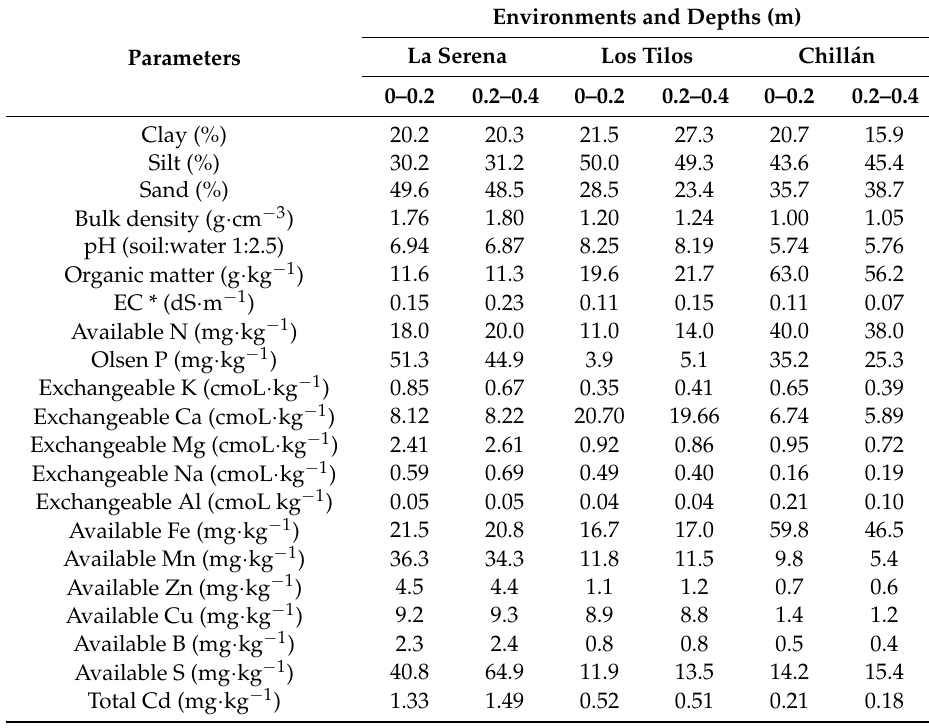
Table 1. Soil physical and chemical properties (0–0.2 and 0.2–0.4 m depth).